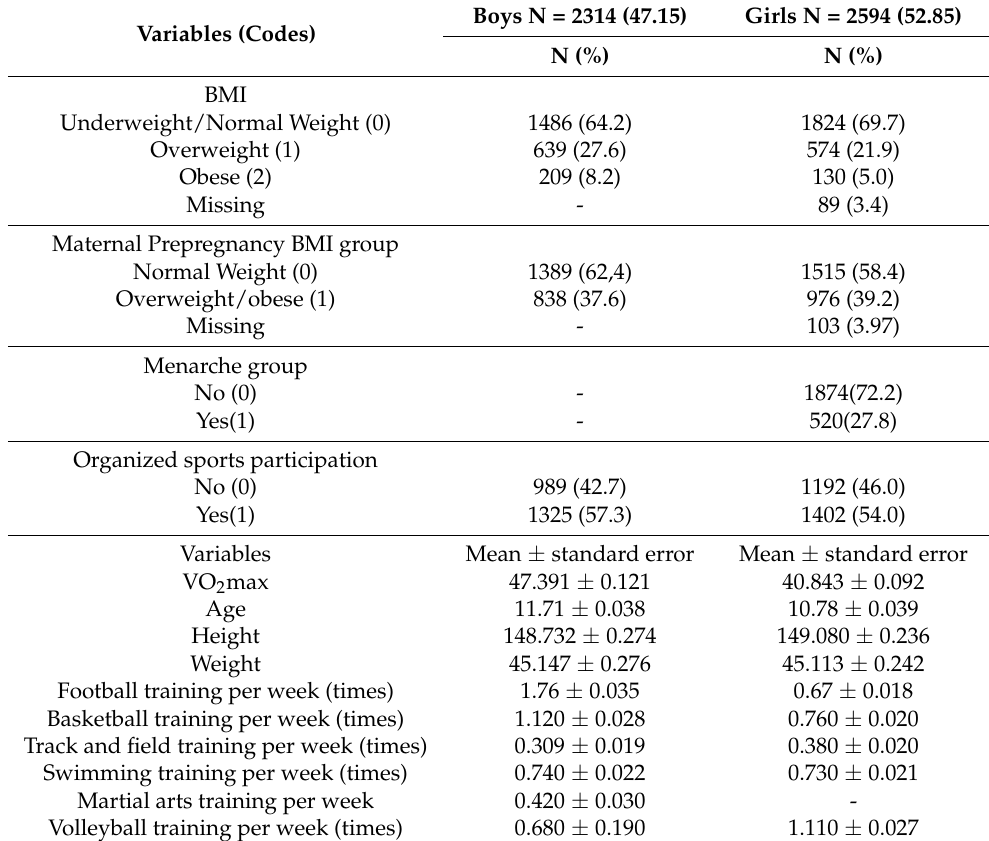
Table 3. Sample descriptive